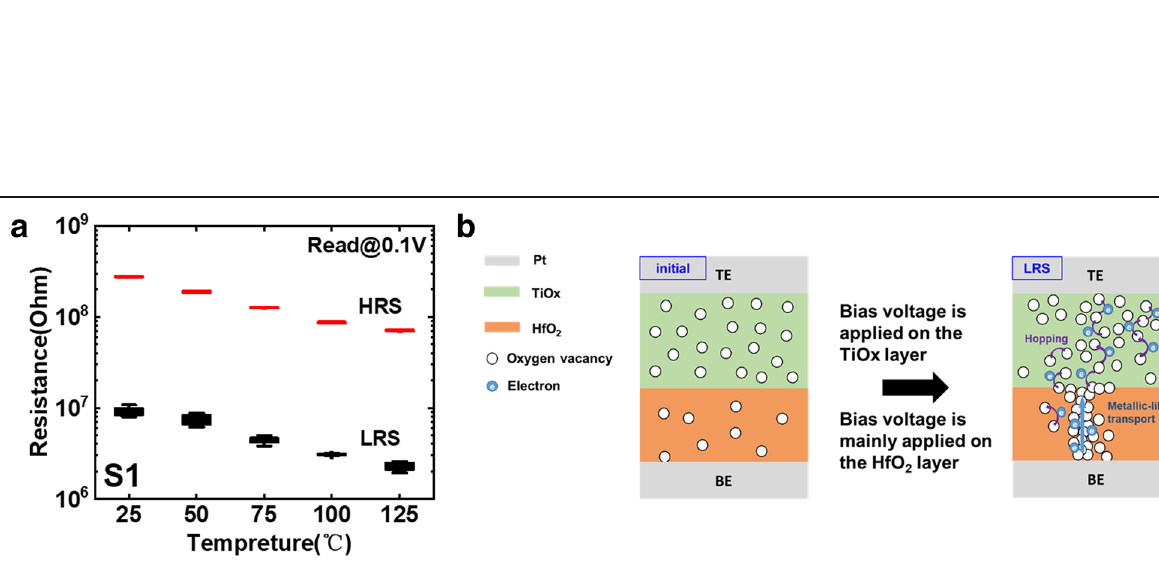
Fig. 9 a The resistance changes with temperature in S1. b The corresponding schematic diagram of conductive mechanism